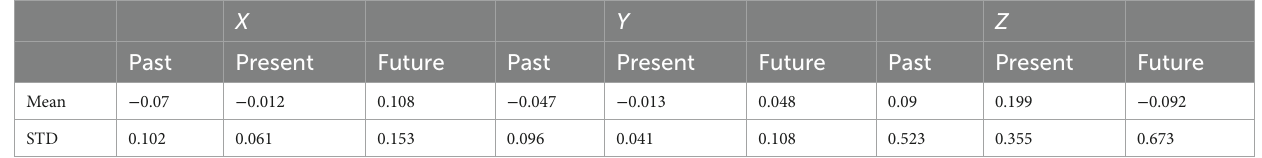
consistent with the previous studies, which have shown that past time zones tend to be represented on the left and future time zones on the right if the participants are familiar with reading and writing rightward. The numbers of participants with those alignment patterns along the Y axis (from bottom to top) are plotted in